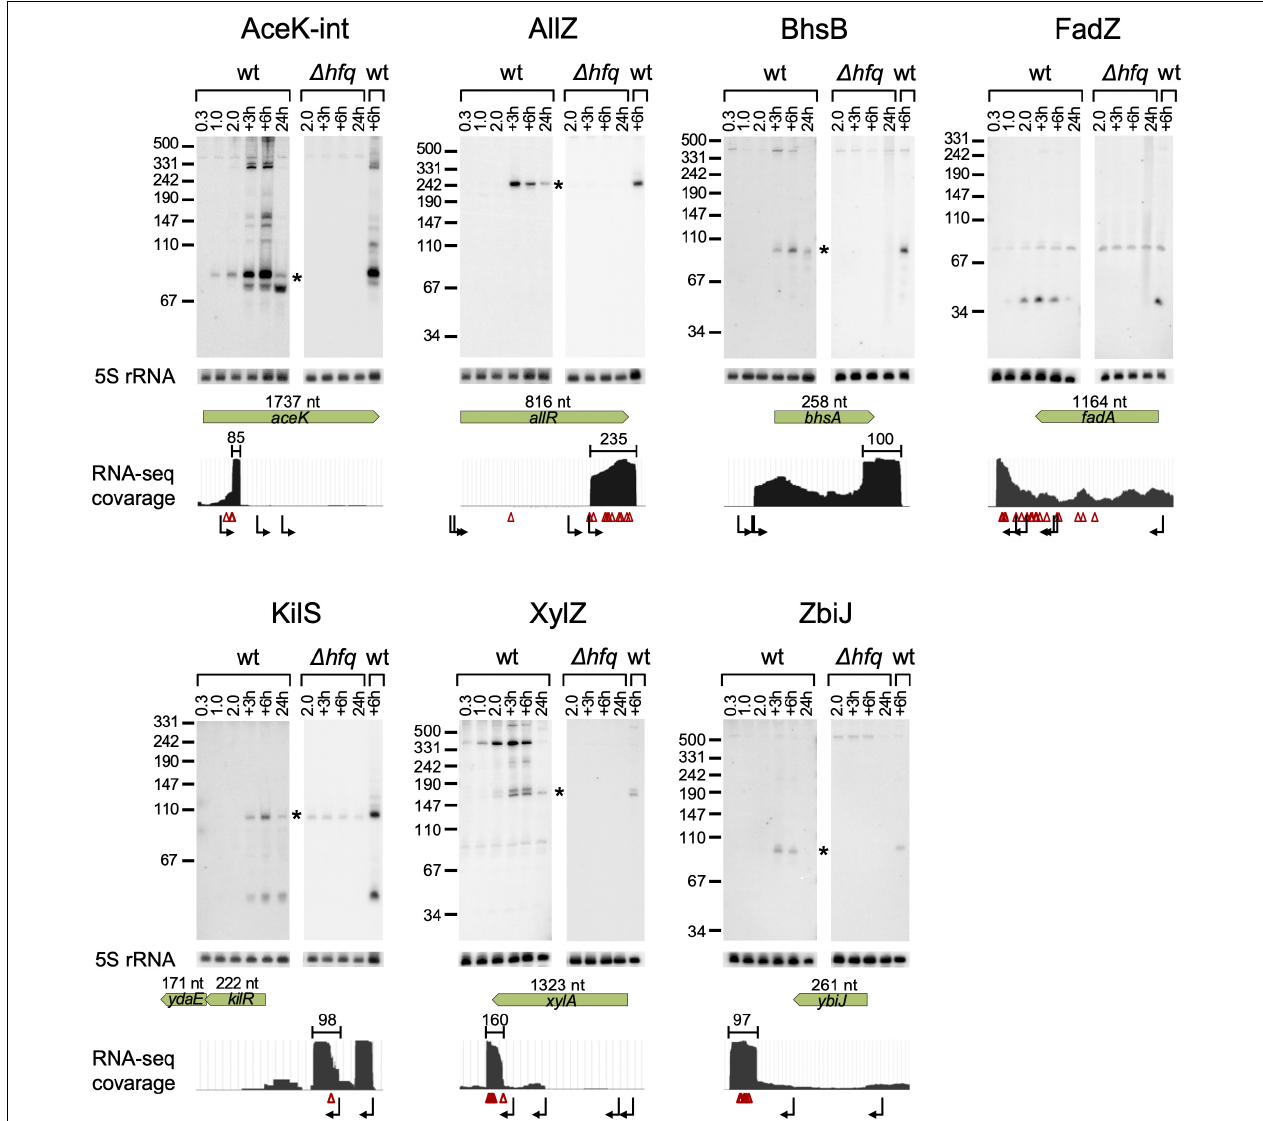
FIGURE 5 | Verification of the novel sRNAs by northern analysis. Total RNA was extracted from wt E. coli and (cid:49) hfq cultures throughout growth. Samples of the wt culture were taken at an OD 600 of 0.3, 1.0, and 2.0, 3 h and 6 h after the culture reached an OD 600 of 2.0 (+3 h and +6 h, respectively) and after 24 h of growth (24 h). Samples of the (cid:49) hfq were taken at an OD 600 of 2.0, 3 h and 6 h after the culture reached an OD 600 of 2.0 and after 24 h of growth. 30 µ g total RNA were subjected to northern analysis using specific probes. The membrane used for the probing of AceK-int was re-used for the probing of AllZ, after the AceK-int probe radio-labeling has faded. 5S rRNA was probed as a loading control. For each sRNA, a coverage plot of RNA-seq library made of total RNA from a stationary phase (6 h growth) culture is shown. The green arrows indicate the coding sequence (CDS) region and gene orientation, with the CDS size above the arrow in nucleotides (nt). The approximated size of each sRNA is indicated above the read coverage plot (nt). Starlet indicates the band fitting in size to the RNA-seq data. Transcription start sites, based on data of Thomason et al. (2015) and Ju et al. (2019), and RNase E cleavage sites, based on data of Clarke et al. (2014) are shown below the read coverage plots along the transcript by bent black arrows and red triangles, respectively. Transcription start and cleavage sites in the vicinity of the suspected sRNA are recorded also in Supplementary Table 6